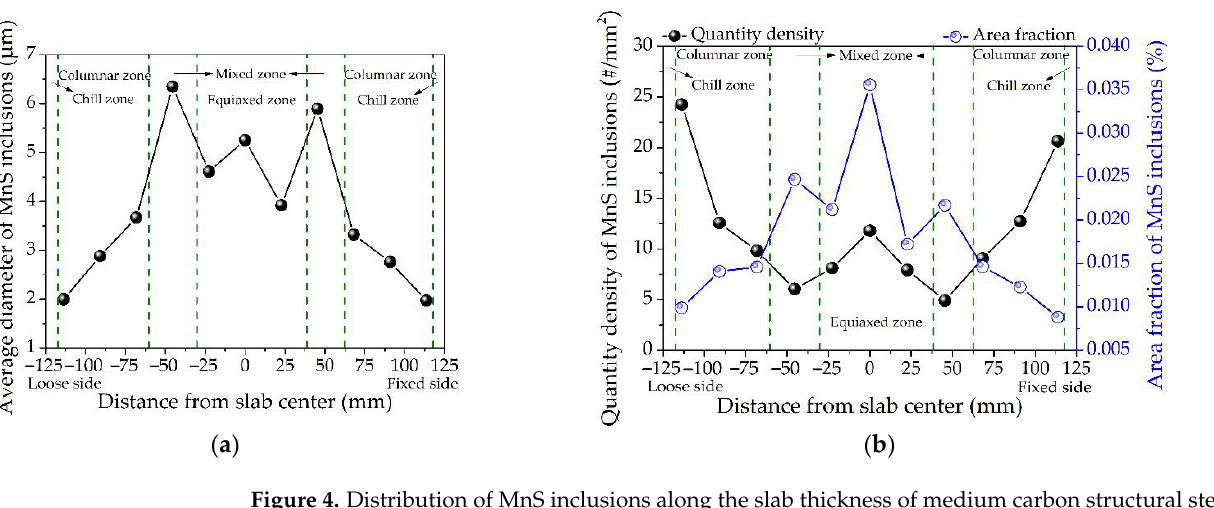
( b ) Figure 4. Distribution of MnS inclusions along the slab thickness of medium carbon structural steel 45#: ( a ) average diameter, ( b ) quantity density and area fraction.